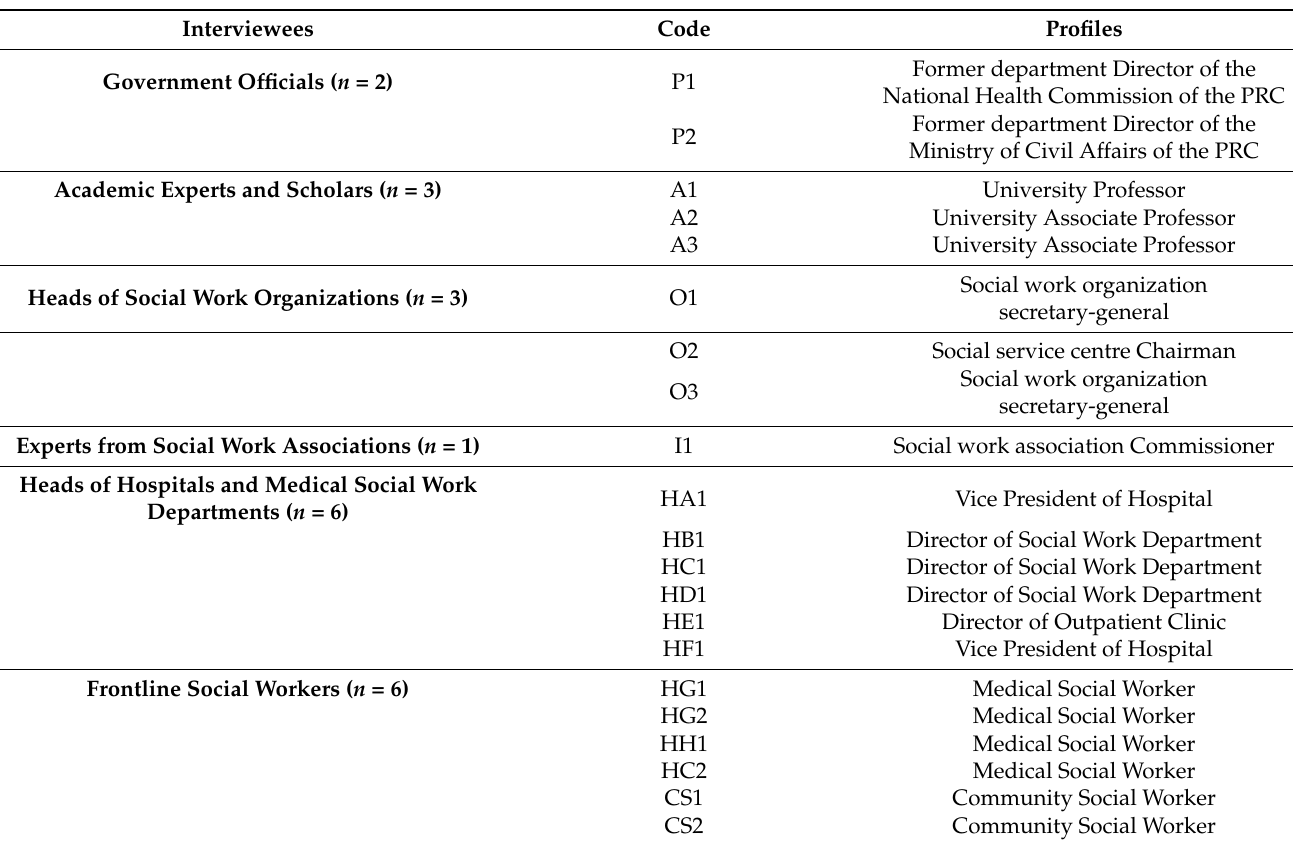
Table 1. List of social workers, experts, and scholars who participated in the key informant